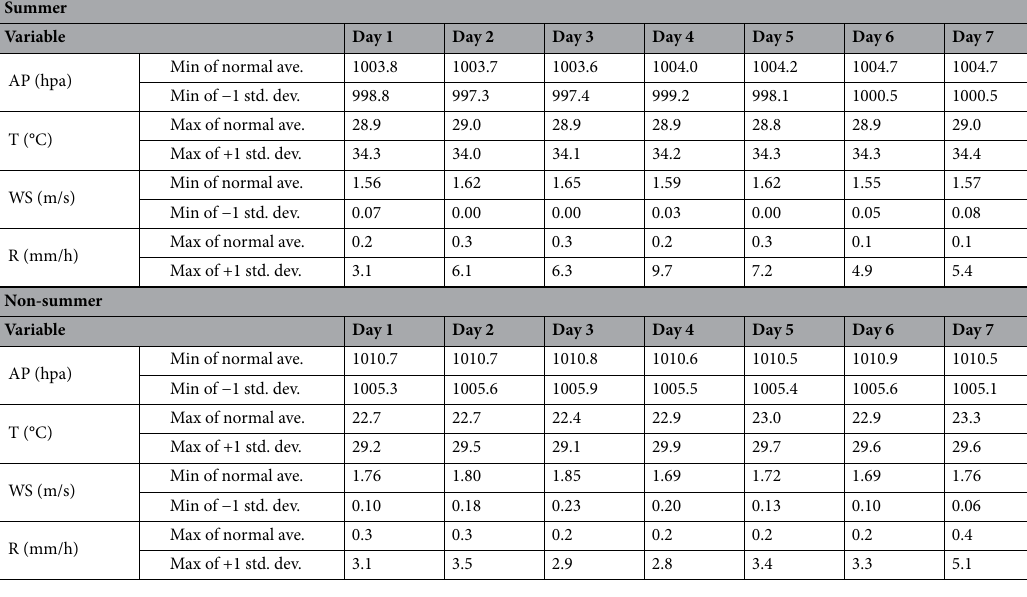
Table 3. Summary of daily normal average conditions and values of positive or negative one standard deviation for each meteorological variable during non-kill summer and non-summer